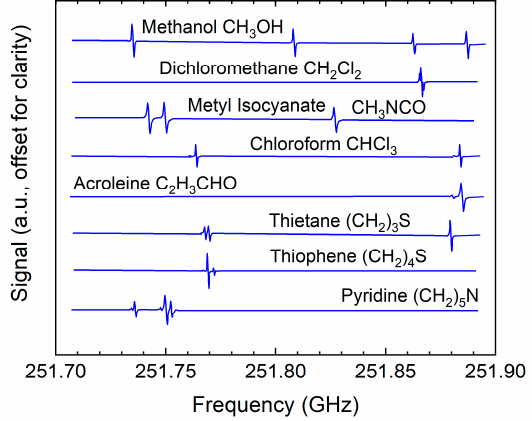
Figure 23. Expanded section of the detected spectrum showing spectral signatures of eight gases. Adapted from [169].